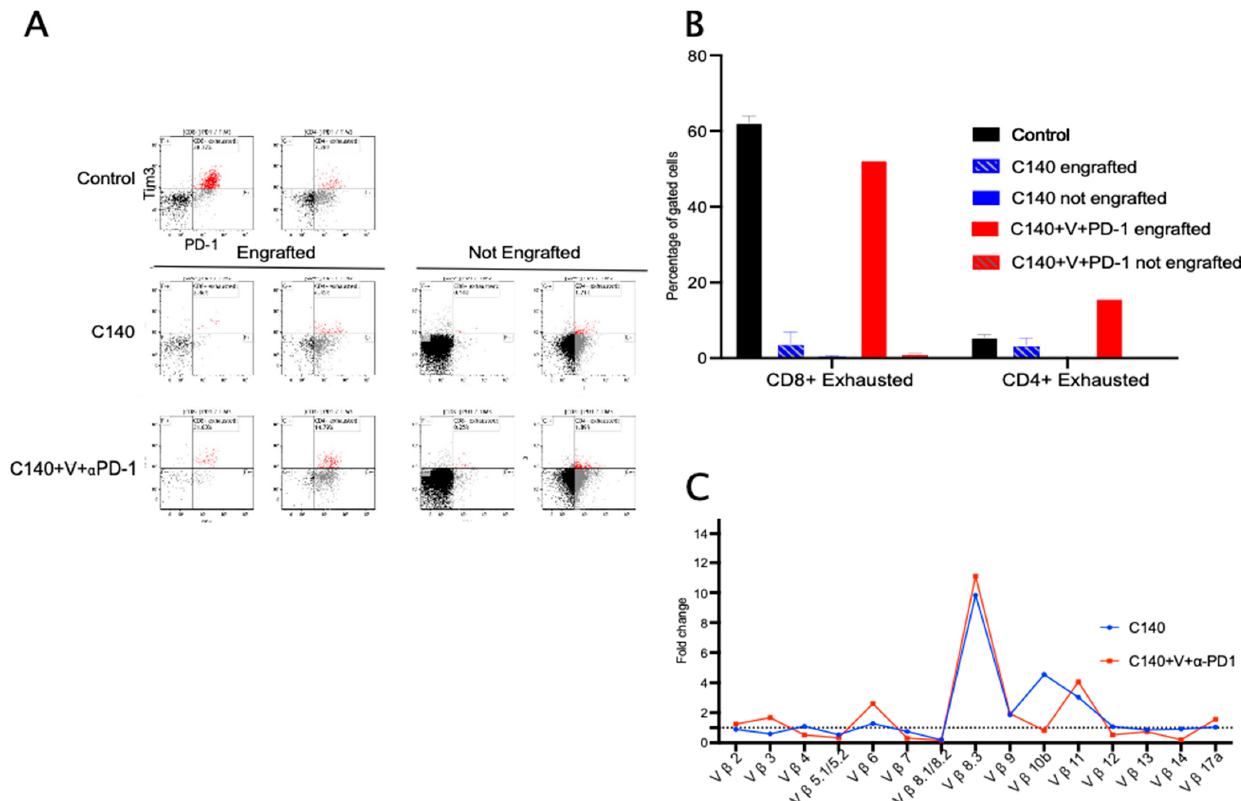
Figure 6. TT in tumor re-challenged mice selects for proliferative and oligoclonal T cells. ( A ) Representative flow cytometry plots showing the percentage of exhausted CD3 + CD8 + cells (defined as CD3 + CD8 + PD-1 + TIM3 + , on the left) and of exhausted CD3 + CD4 + cells (defined as CD3 + CD4 + PD-1 + TIM3 + , on the right) from the spleen of a control (upper panel), C140-engrafted (middle on the left), C140-not-engrafted (middle on the right), C140+V+anti-PD-1-engrafted (bottom on the left) C140+V+anti-PD-1-not engrafted (bottom on the right) mouse. Cells were gated according to physical parameters. ( B ) Quantification of exhausted CD3 + CD8 + cells (defined as CD3 + CD8 + PD-1 + TIM3 + ) and of exhausted CD3 + CD4 + cells (defined as CD3 + CD4 + PD-1 + TIM3 + ) from the spleen of a control (black), C140-engrafted (dashed blue), C140-not-engrafted (blue), and C140+V+anti-PD-1-engrafted (dashed red) and C140+V+anti-PD-1-not engrafted (red graph) mice. Two C140-treated mice did not engraft the lymphoma, one TT-treated mouse had lymphoma. ( C ) CD3 + CD8 + TCR clonality in the spleen of lymphoma re-challenged mice. On the x -axis, 15 common V β chain recombinations are present, whereas on the y -axis the fold change increase is compared with engrafted mice (represented as dashed lines in the graph).